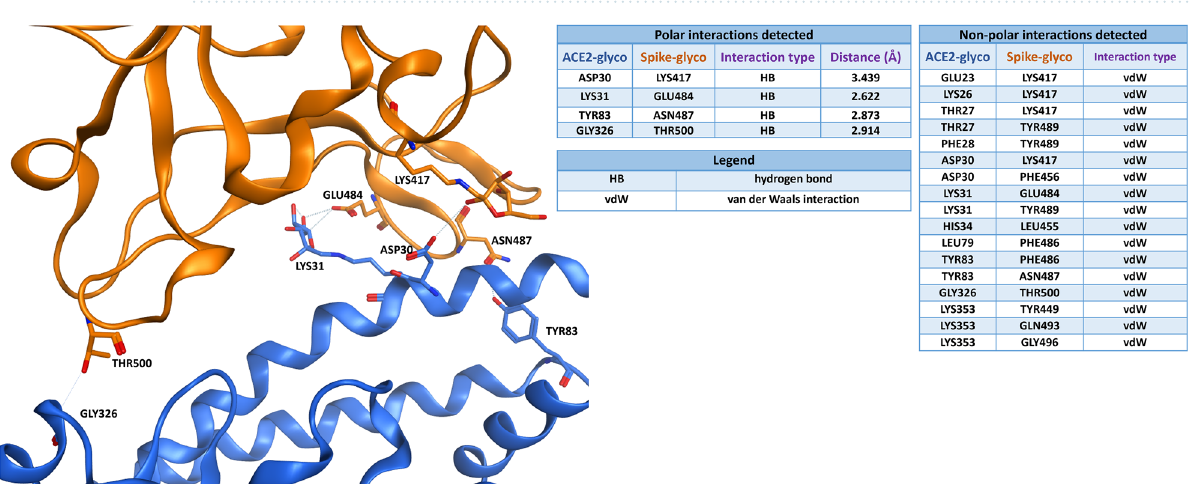
Figure 5. Glycated viral Spike protein RBD (orange) binding to glycated ACE2 receptor (blue). The tables on the right report the polar and the non-polar interactions in which the residues on the interface are involved. For the polar interactions, also the distance between the interacting atoms (measured in angstroms) is reported in the table. To get a better visual representation of the contacts, just the residues engaged in the polar interactions are labelled in the 3D image on the left, while all the non-polar interactions are